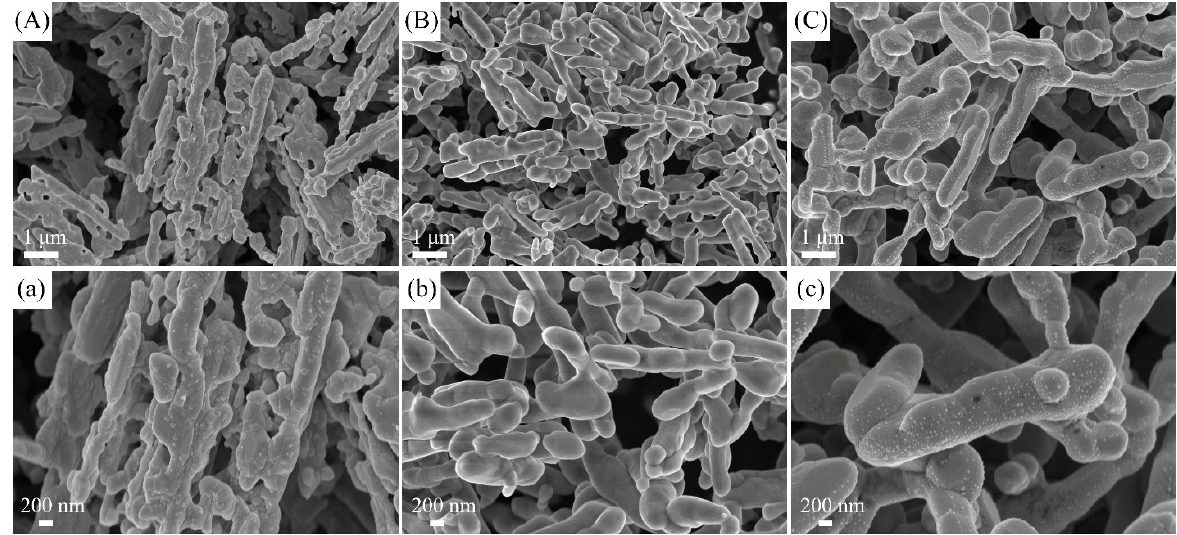
Figure 3. SEM images of ( A , a ) NCM750, ( B , b ) NCM800, and ( C , c ) NCM850.